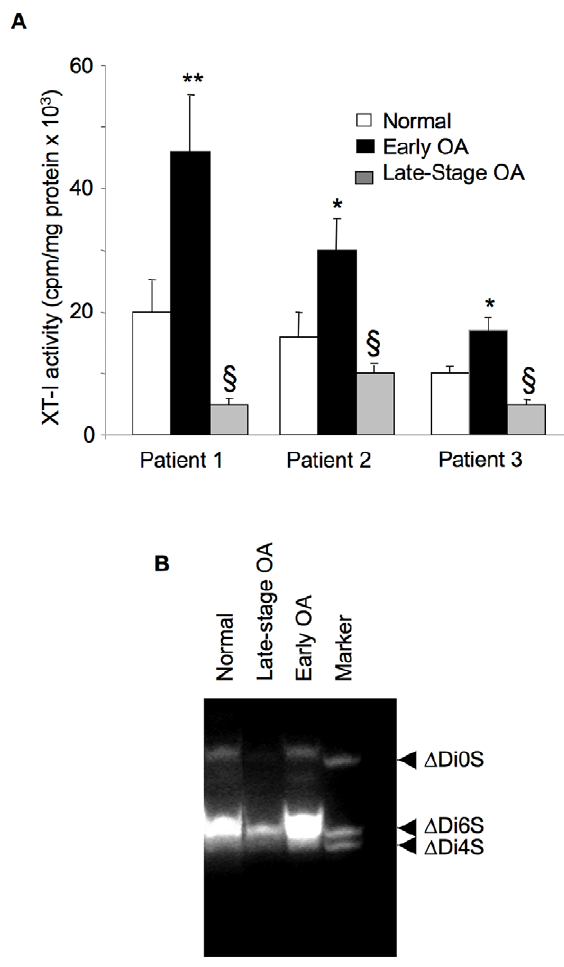
Figure 3. Analysis of xylosyltransferase activity and GAG chain composition. (A) xylosyltransferase activity from normal, early OA and late-stage OA cartilage of three representative patients. Data are mean 6 SD of 3 experiments per parameter, per joint, per patient. **Significantly ( P , 0.01) higher than all groups; *significantly ( P , 0.01) higher than normal and late groups; 1 significantly ( P , 0.05) lower than normal. (B) GAG chain composition in human cartilage explants as determined by FACE. Proteinase K-digested cartilage explants contain- ing equal amounts (5 m g) of GAGs, as determined by uronic acid assay from each group, were digested with chondroitinase ABC and the disaccharides obtained were fluorotagged and derivatized. Disaccha- rides were run on a monocomposition gel and gels are representative images from 3 experiments per parameter, per joint, per patient. Markers are D Di0S, nonsulfated chondroitin-unsaturated disaccharide; the expression of this glycosyltransferase and sulfated-GAG content in human OA cartilage.